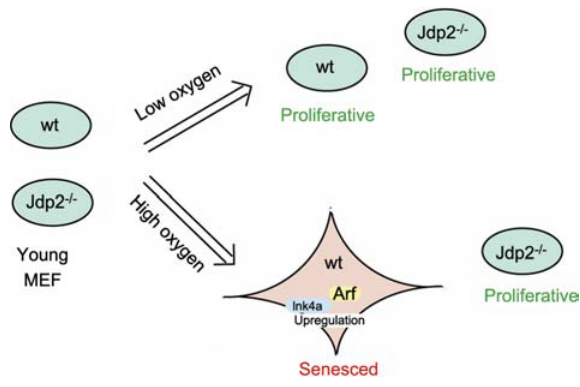
Figure 5 JDP2-deficient mouse embryo fibroblasts (MEFs) escape replicative senescence.